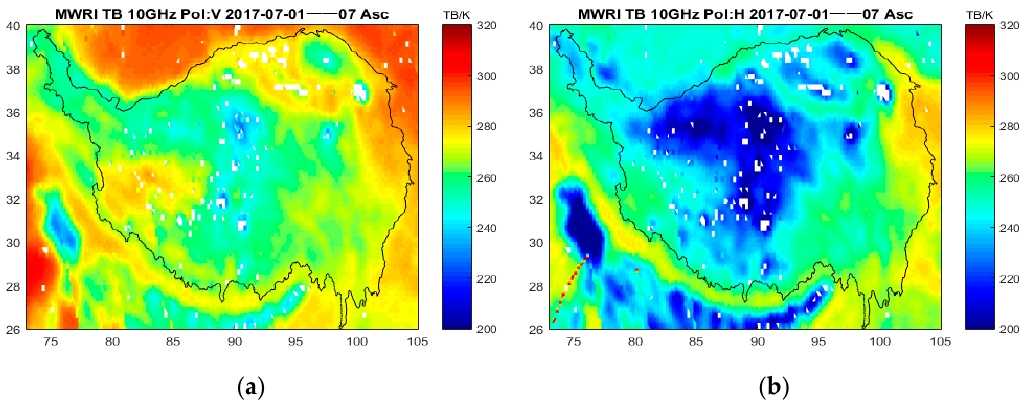
Figure 1. Microwave brightness temperature on 1–7 July 2017 (clear sky, land only, 10 GHz, vertical polarization): ( a ) vertical polarization; and ( b ) horizontal polarization.